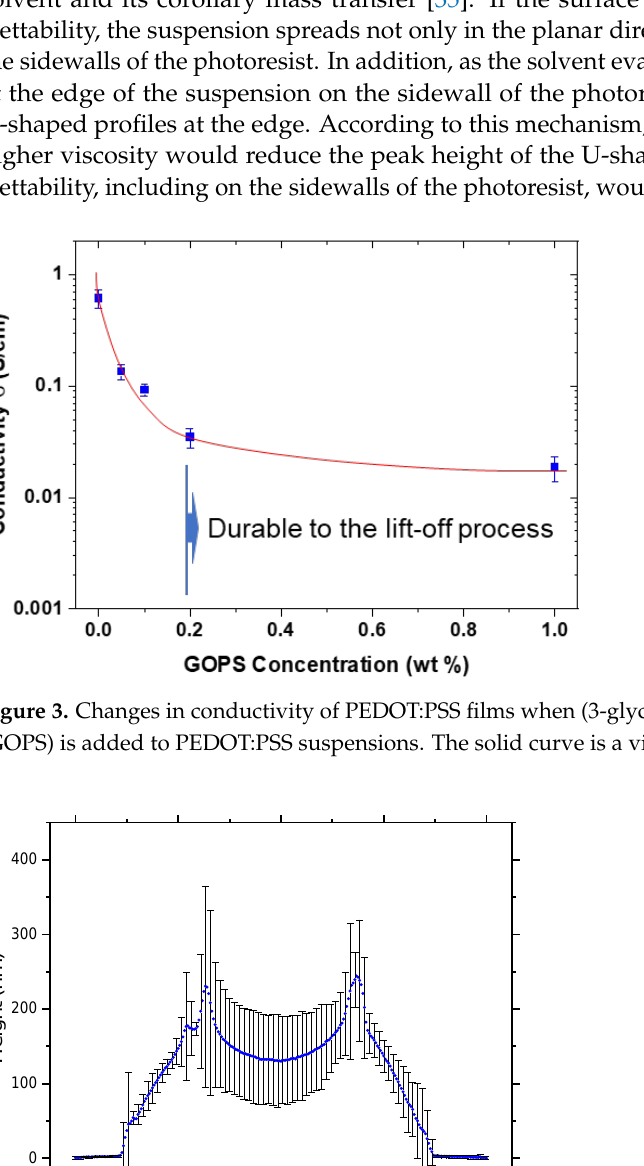
Figure 4. Height profiles of the patterned PEDOT:PSS lines made using the traditional process. The error bars show the difference in the maximum and minimum values at each position.